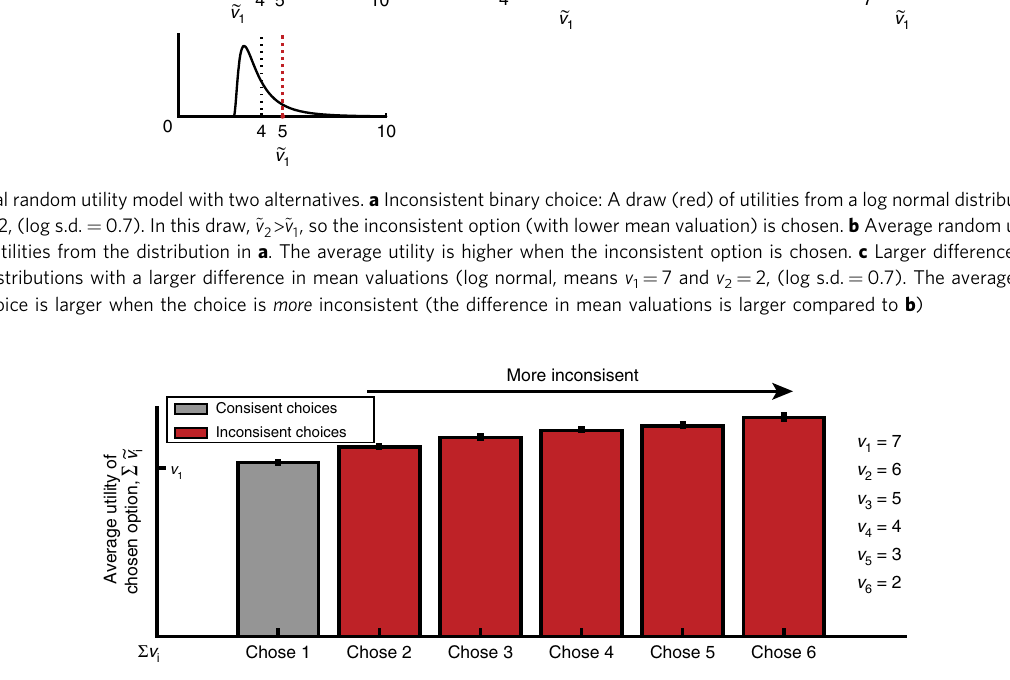
Table 1 Simulation results SID Gumbel dist.